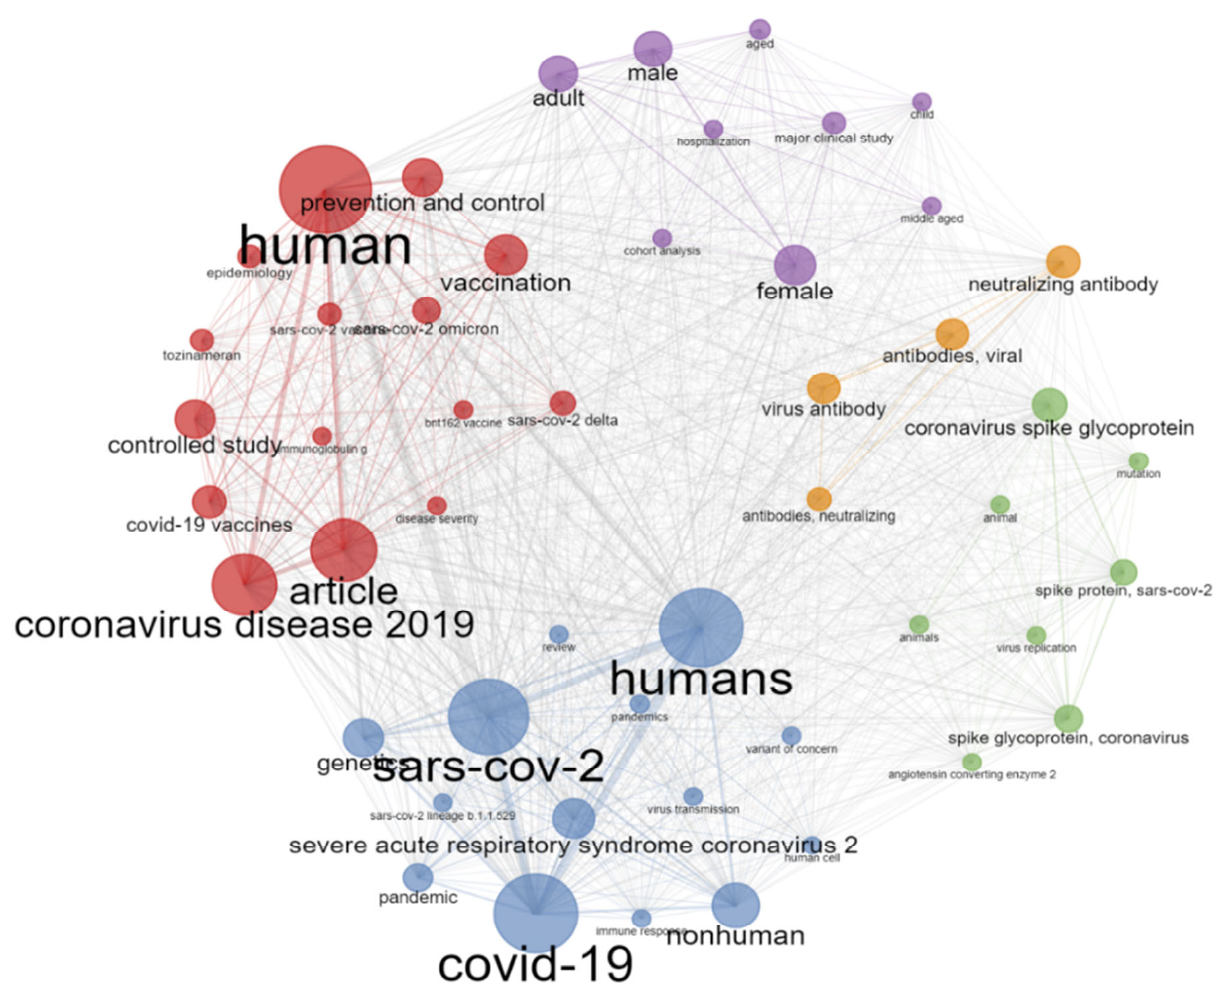
Figure 12. Co-word network visualization: various colors indicate word clusters; label size indicates how frequently each keyword occurs. The same cluster of keywords is frequently listed together.